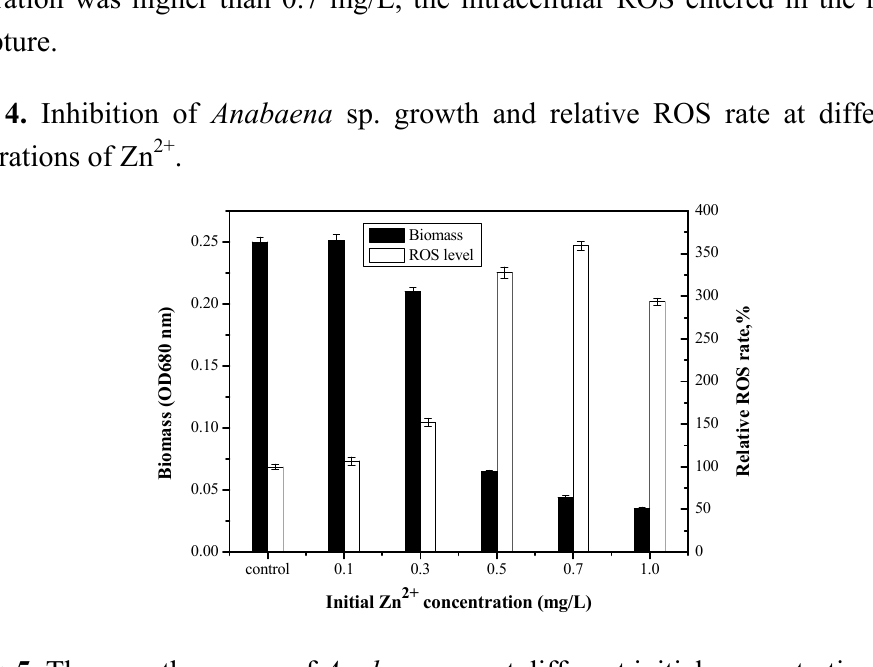
Figure 5. The growth process of Anabaena sp. at different initial concentrations of Zn 2+